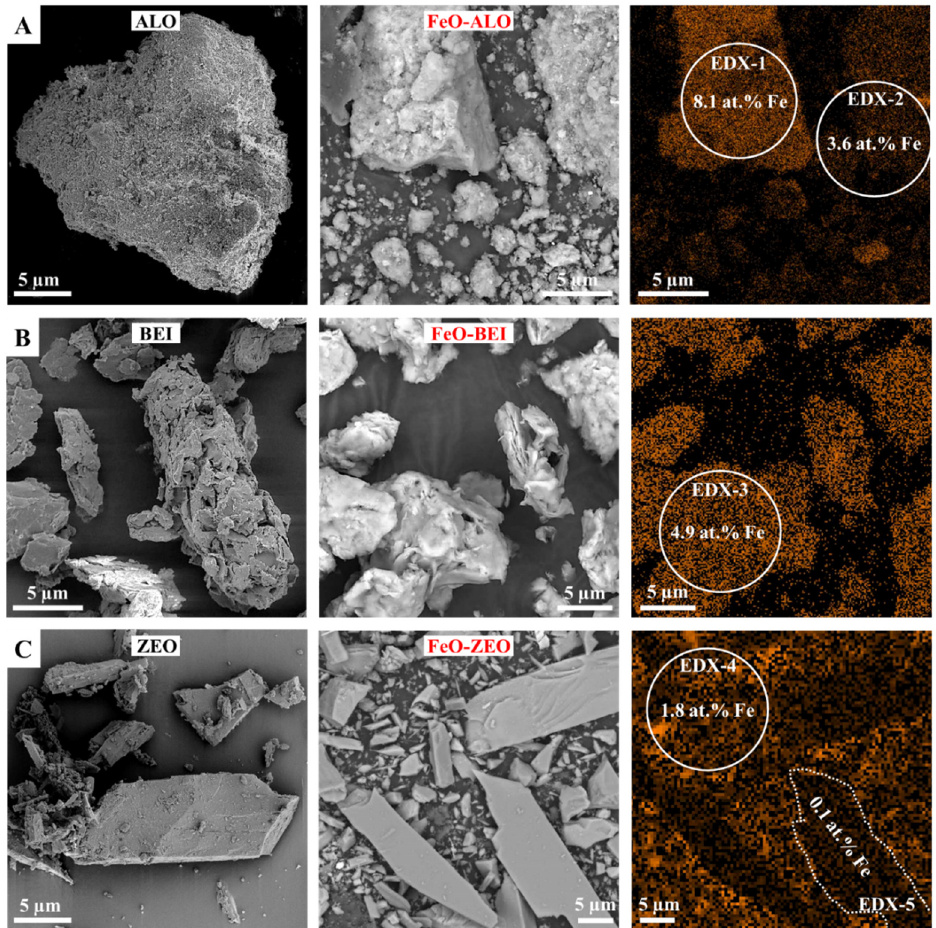
Figure 4. SEM images of natural (first panel) and FeO-modified (second panel) ALO ( A ), BEI ( B ) and ZEO ( C ) adsorbents. Fe distribution maps of the images shown in the second panel are provided on the right. Marked areas indicate positions of EDX measurements (Supplementary Material Figure S3).